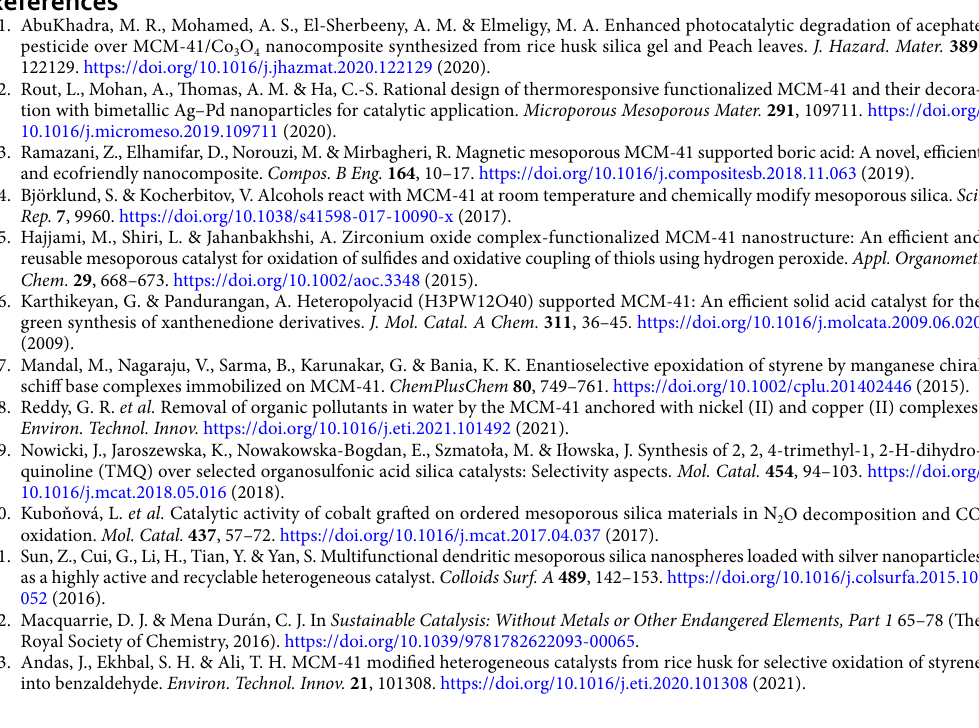
Table 3. Comparison of the catalytic activity of the MCM-41-APS-PMDA-NHSO 3 H ( 1 ) with other catalysts.